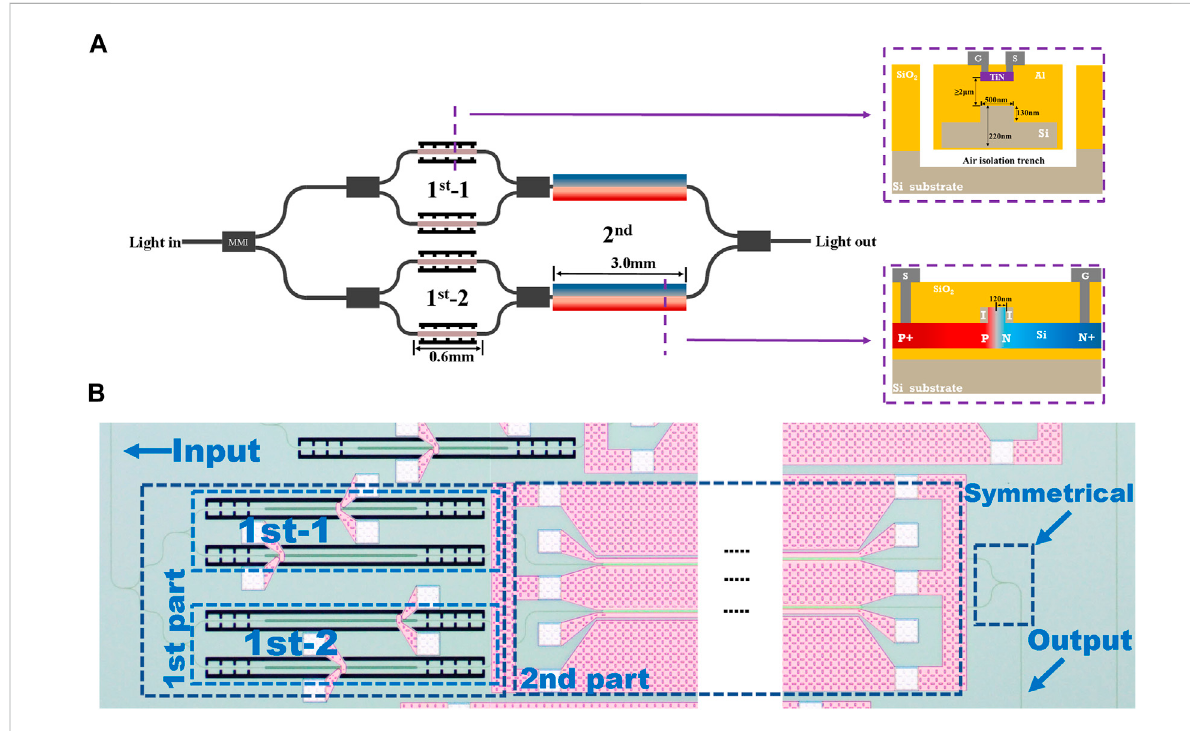
FIGURE 1 (A) The cross section of the light-intensity-balanced MZM. (B) The optical microscope image of the